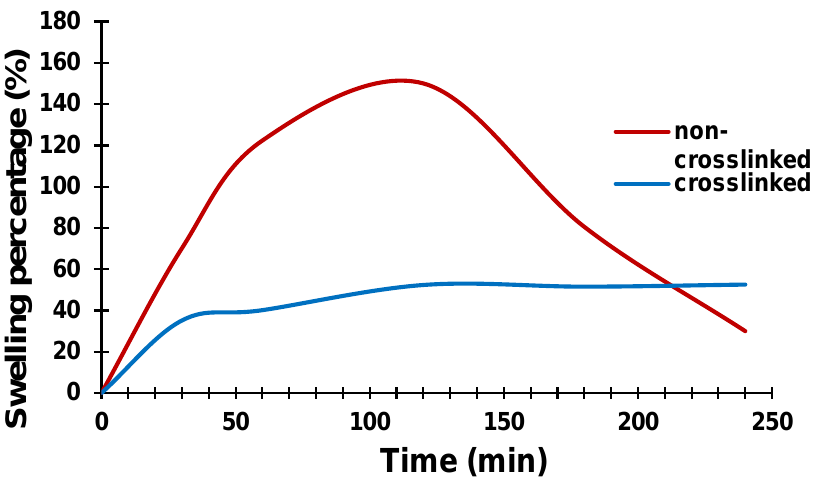
Figure 12. Swelling percentage of the non-crosslinked and a crosslinked conductive film.